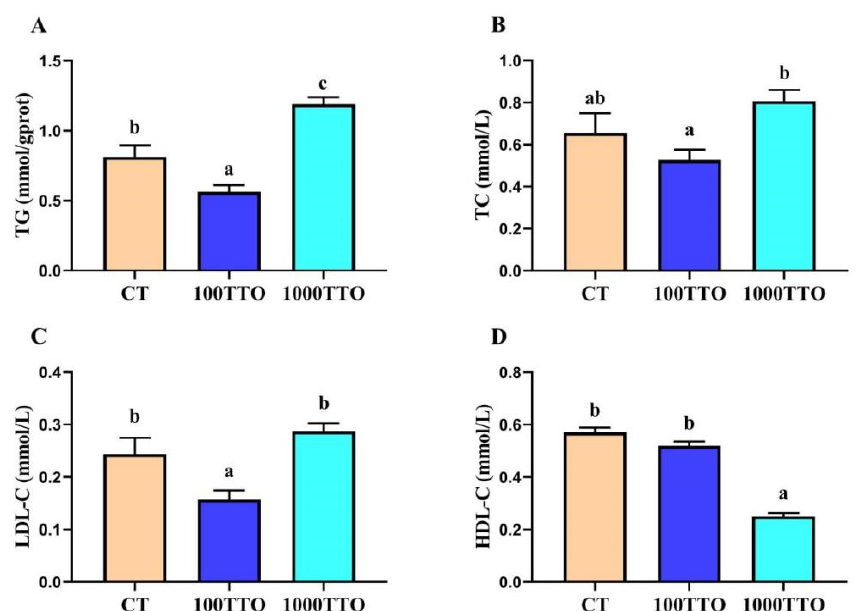
Figure 3. Effect of dietary TTO levels on lipid contents of M. rosenbergii . ( A ) TG content in hepatopan- creas. ( B – D ) TC, LDL-C, HDL-C content in hemolymph. The significant difference between the three